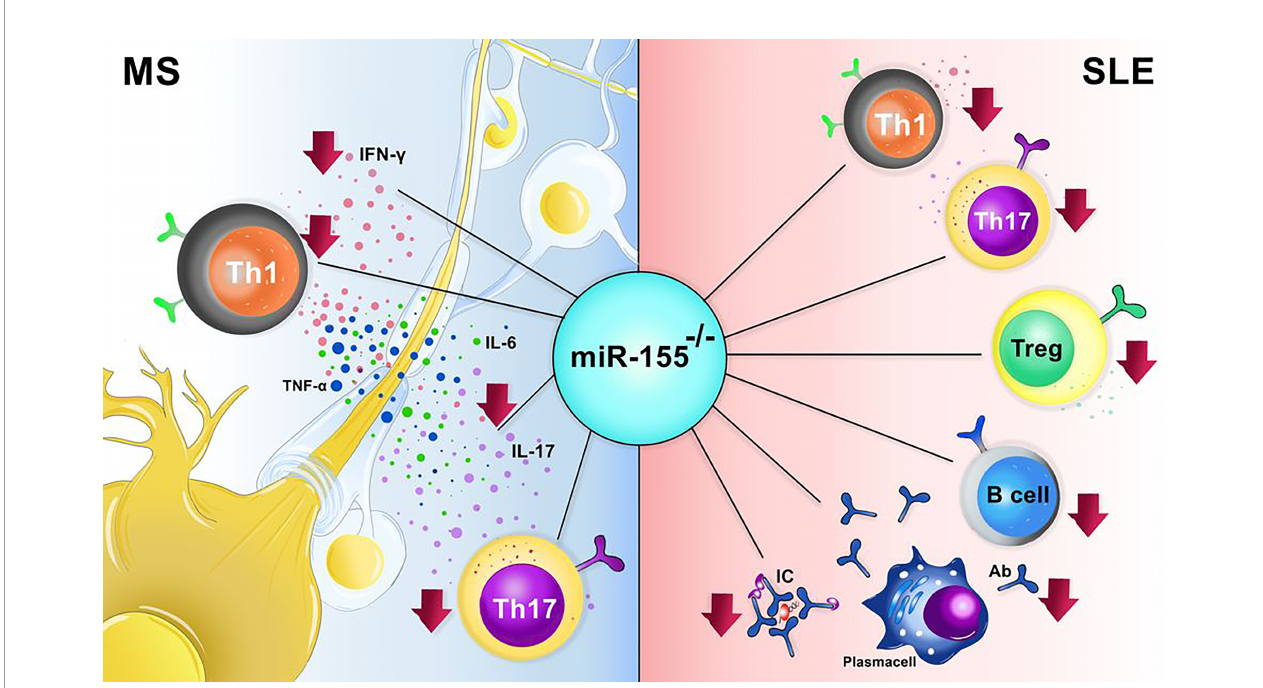
FIGURE 2 | The effect miR-155 -/- in animal models of systemic lupus erythematosus (SLE) and multiple sclerosis (MS). In MS the absence of miR-155 results in decreased number of Th1, Th17 and also decrement procution of IL-17, IL-6, TNF- a , and IFN- g . In SLE, lack of miR-155 causes a marked reduction in Th1, Th17, Treg, B cells, and plasma